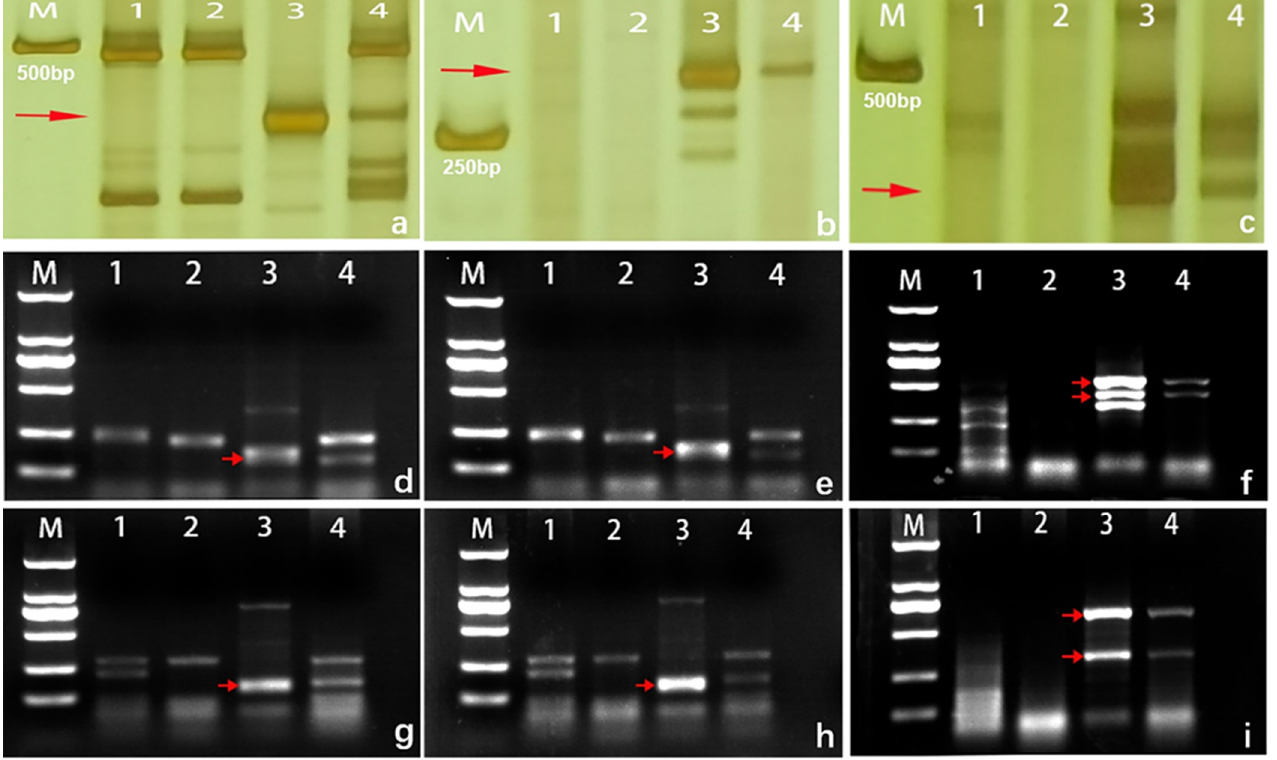
Table 1. Evaluation of agronomic traits of 17DM48 and its parents.